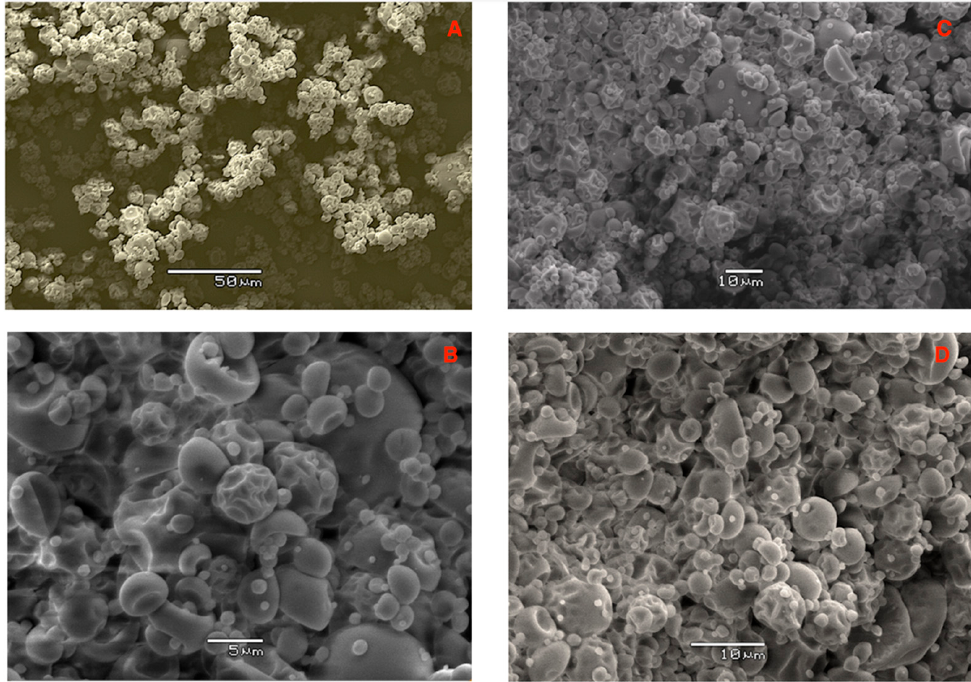
Figure 2. SEM images of the spray ‐ dried grape pomace powder encapsulated with 20% maltodextrin for the spray ‐ drying condition of 120 °C inlet air temperature. Different scales are shown: 50 μ m ( A ); 5 μ m ( B ); and 10 μ m ( C , D ).